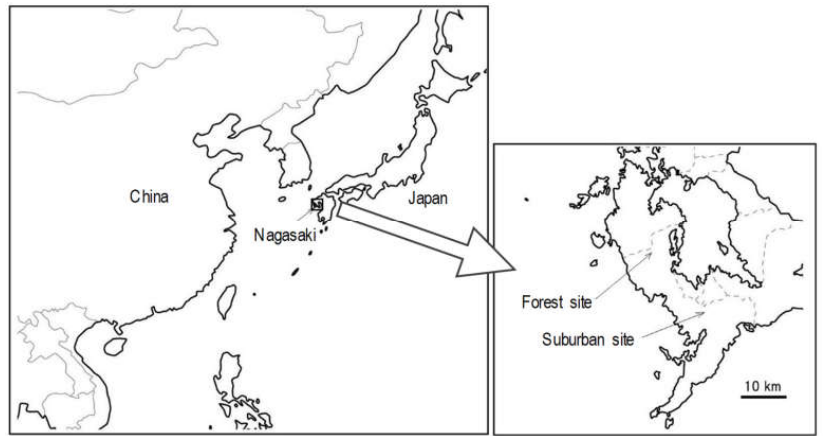
Figure 1. Location of the sampling sites.